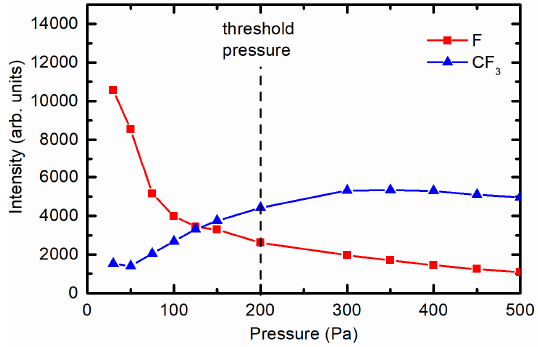
Figure 10. OES intensity of the F emission line at 703 nm and the CF 3 band at 580 nm versus CF 4 pressure.